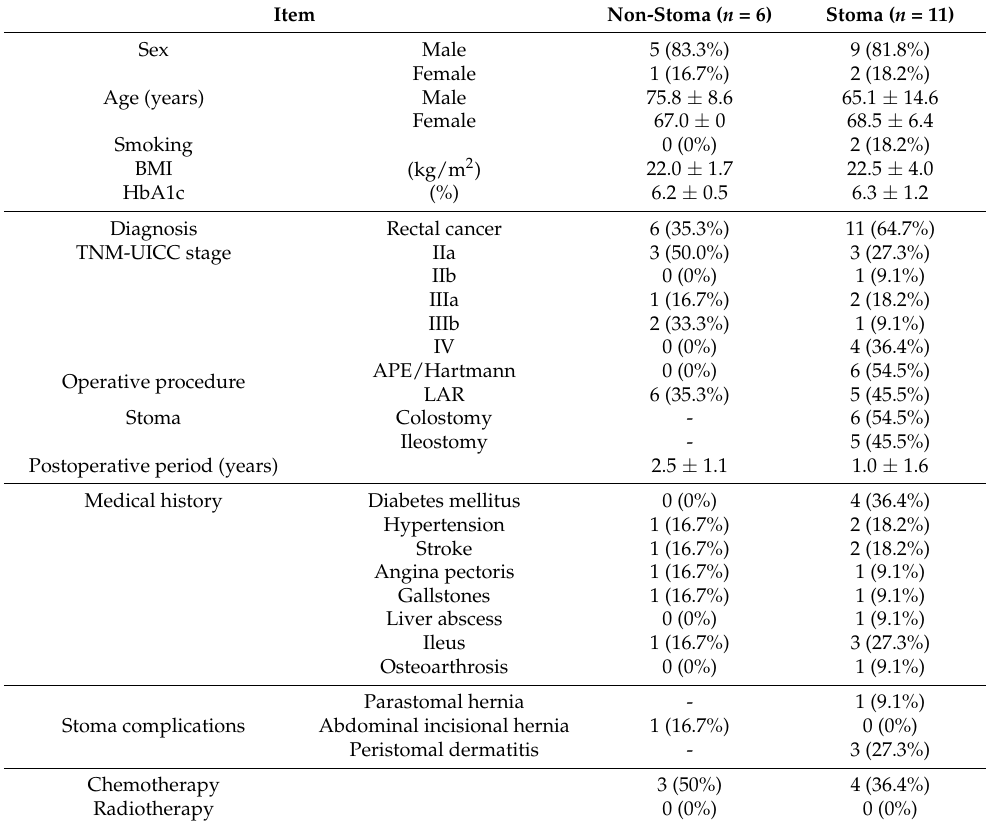
Table 1. Participant